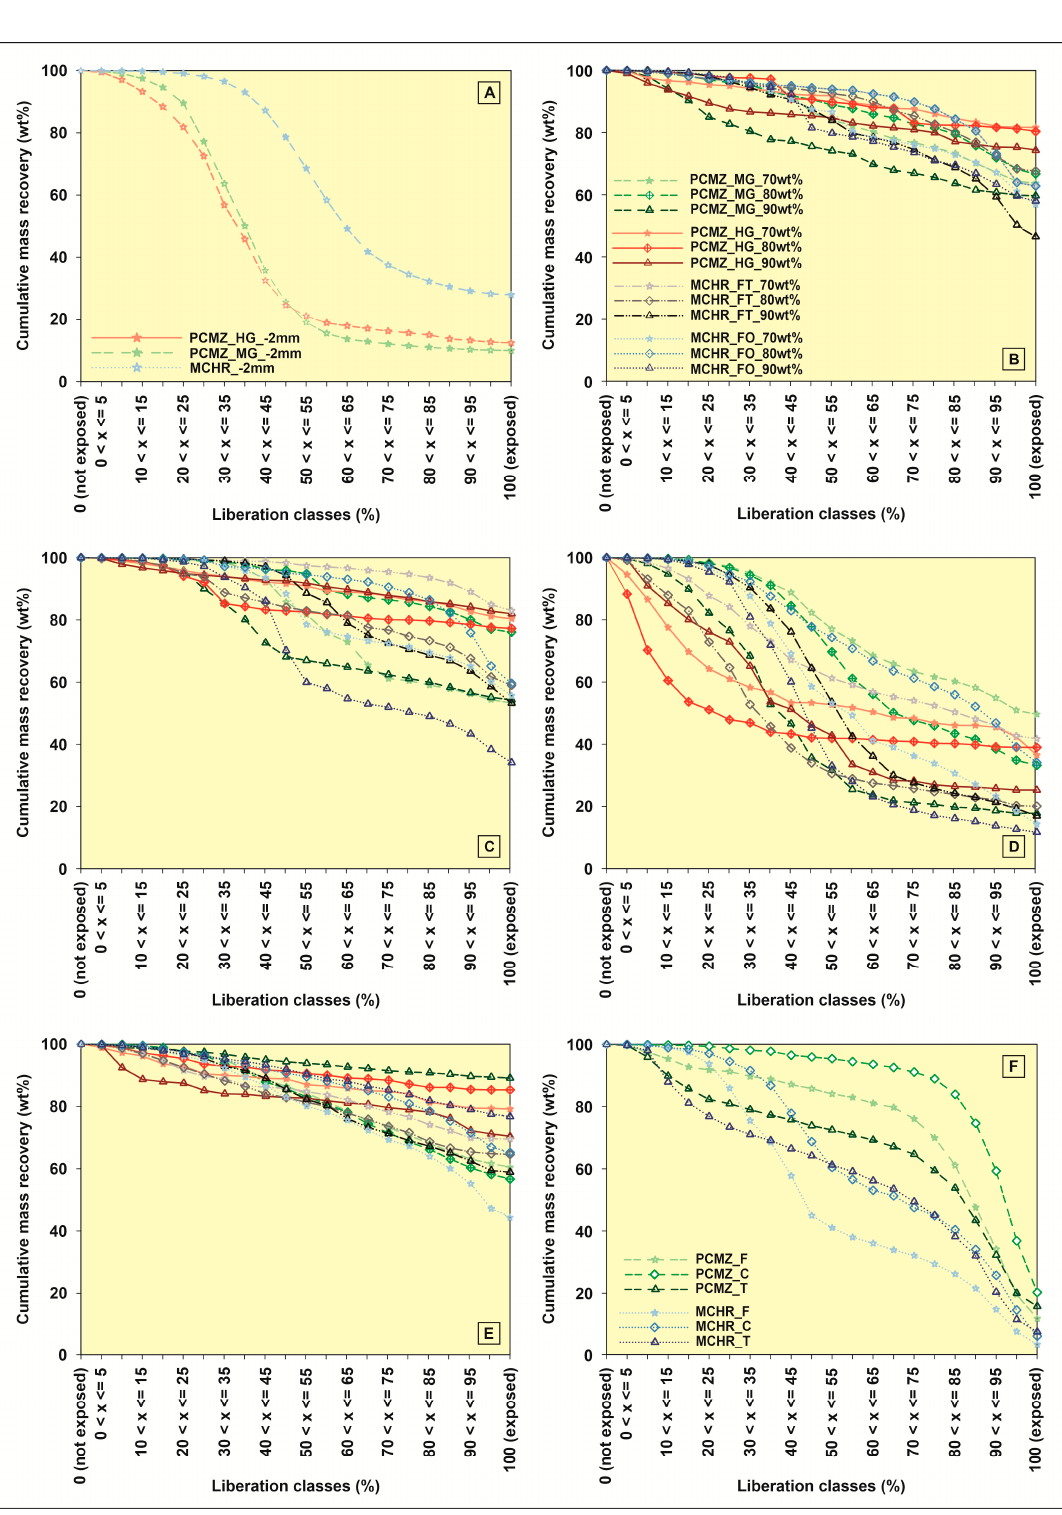
Figure 10. Plot of cumulative liberation yield (‘cumulative mass recovery%’) versus the level of liberation (‘exposure’) of chromite. ( A ) − 2 mm crush samples. ( B ) Feed samples. ( C ) Concentrate samples. ( D ) Middlings samples. ( E ) Tailings samples. ( F ) PCMZ and MCHR samples collected from the concentrator plant.